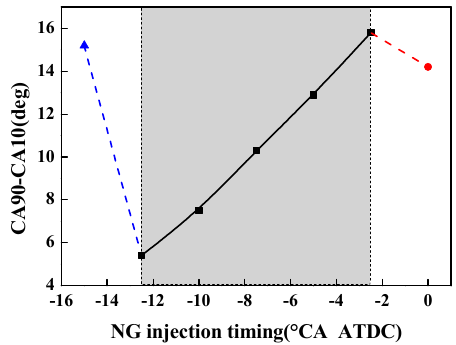
Figure 9. Variation of combustion duration and NG injection timing.